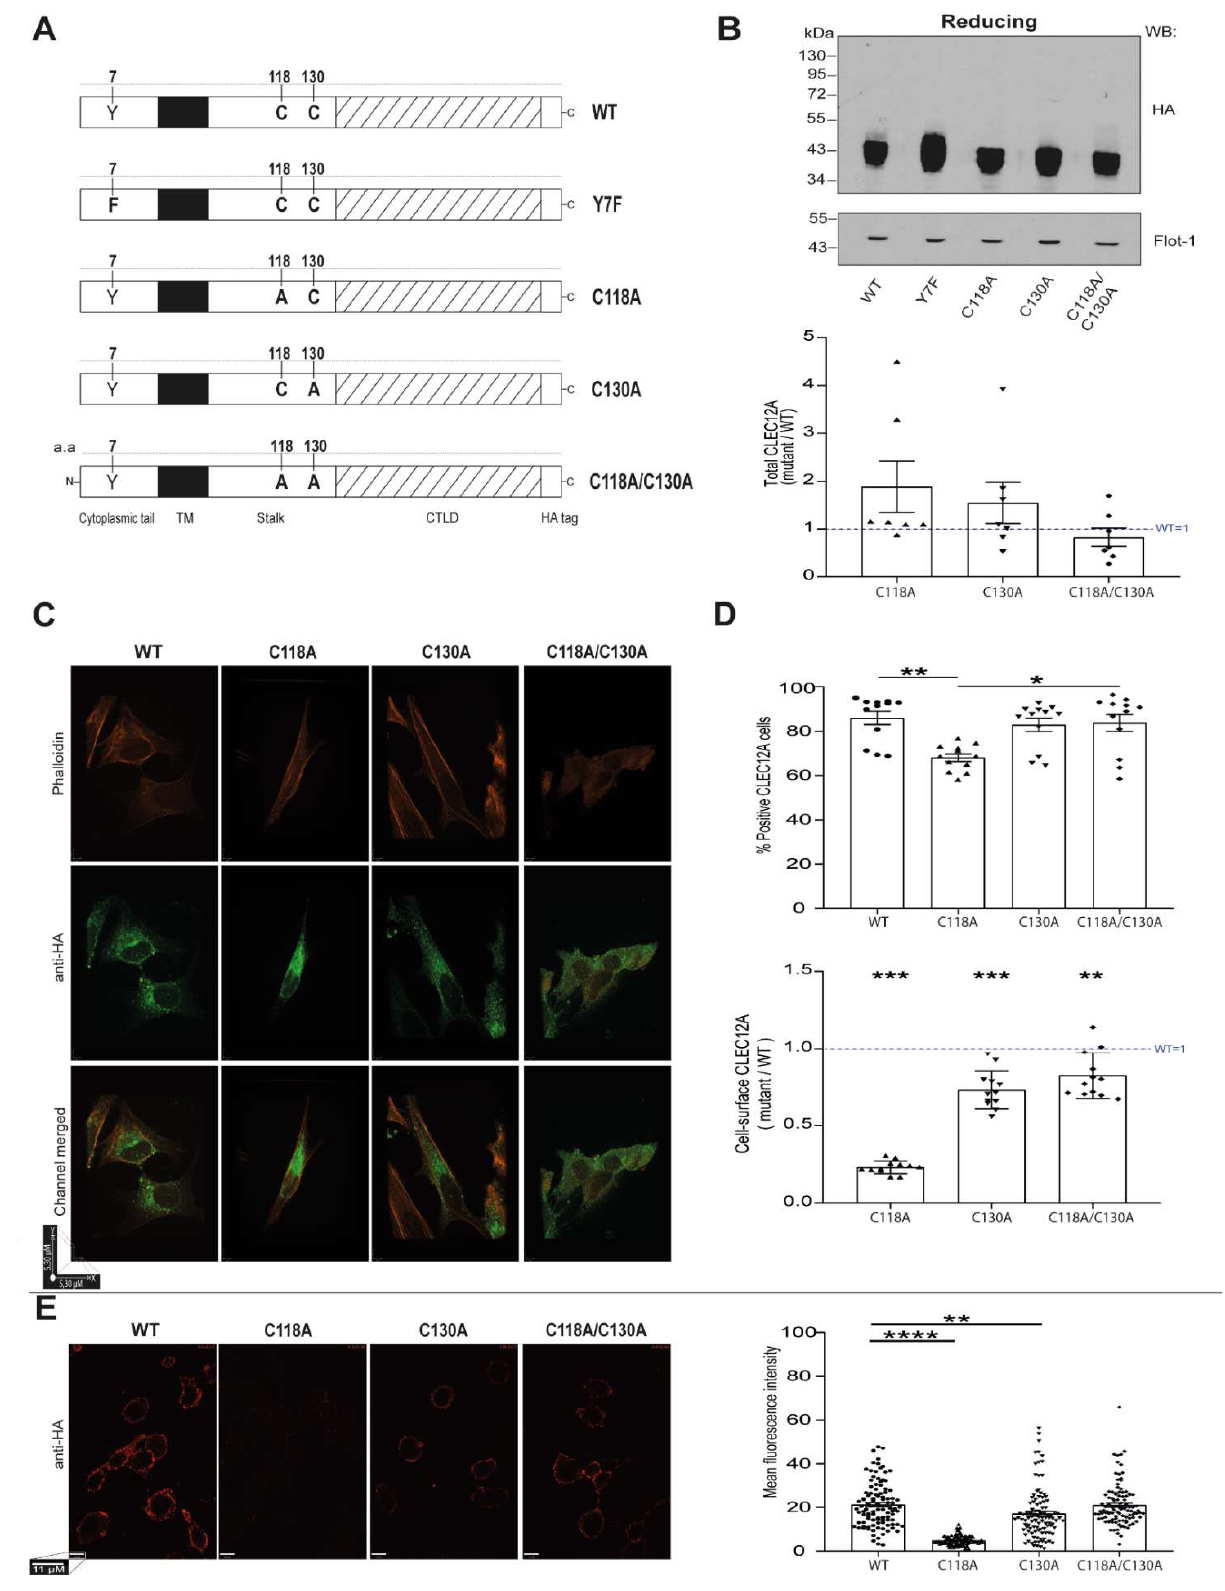
Figure 1. Stalk domain C118 and C130 residues regulate CLEC12A cell-surface expression and oligomerisation. ( A ) A schematic diagram of the constructs used in these experiments. Wild-type CLEC12A (WT), CLEC12A ITIM mutant (Y7F), and the C118A, C130A and C118A/C130A double mutants. All constructs are HA-tagged at the C-terminus. ( B ) Western blot of HeLa cells transiently transfected with the constructs was performed with an anti-HA and anti-flotillin-1 antibody (loading control) . Densitometry analysis of the Western blot is shown in the graph below the gel . ( C ) Confocal microscopy of